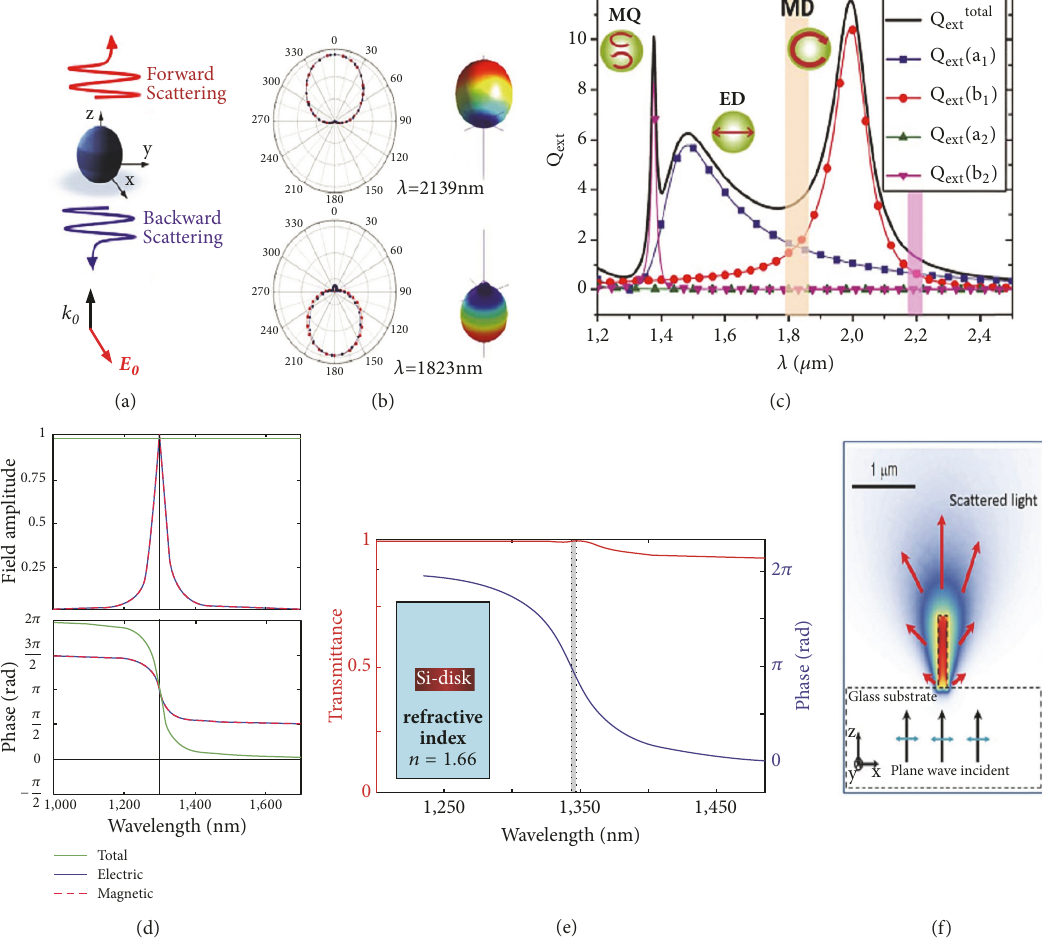
Figure 11: (a) Diagram of the forward and backscattering characteristic of micron-sized dielectric particles. (b) Scattering plot of a 240 nm germaniumsphere; refractiveindex 𝑛 𝑠𝑝 = 4 isaconstantandpositivevalueinthiswavelengthrange. Twopolarizations,paralleltotheincident electric field (TM or p-polarization) or consistent with the plane of incidence (TE or s-polarization) are all considered. (c) The interaction of the total extinction profile 𝑄 𝑒𝑥𝑡 (black curve) with the wavelength is determined by the contribution of every parameter in the expansion of Mie [21]. The blue line corresponds to the contribution of the dipole and the red line to the contribution of the magnetic dipole, and approximately 1.4 microns pink depends on the magnetic quadrupole moment. (d) The phase and amplitude of the scattering field can be used as a function of wavelength of the ideal wavelength array, with electric and magnetic dipole resonance of the same intensity and width under plane wave illumination. (e) Numerical calculation of the transmission intensity (red line) and phase (blue line) of a silicon nanorod with a diameter of 484 nanometers and a height of 220 nanometers embedded in a homogeneous medium with the best optimal refractive index (n = 1.66). The resonance happens at a designed wavelength of approximately 1340 nanometers with a phase coverage of 2 𝜋 . (f) Finite element simulation of the near-field distribution of scattered light in a circular amorphous silicon nanopillar (radius = 75 nm, height = 750 nm) as an example. (a, f) Corresponds to [22]; (b, c) Corresponds to [23]; (d, e) Corresponds to [24]